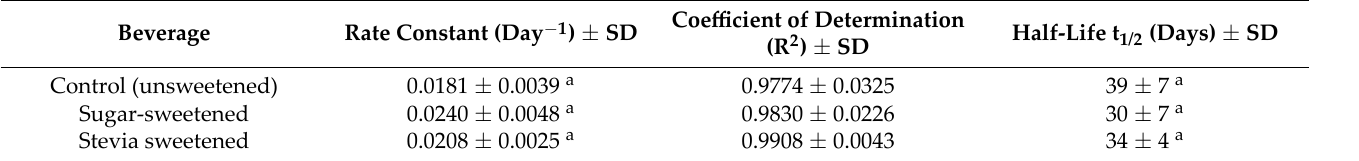
Figure 1. Anthocyanin degradation in Roselle beverages over 90 days of storage at 21 °C. Table 1. Summary of kinetic data on anthocyanins from a 90‑day real‑time study with unsweetened and sweetened Roselle beverages.